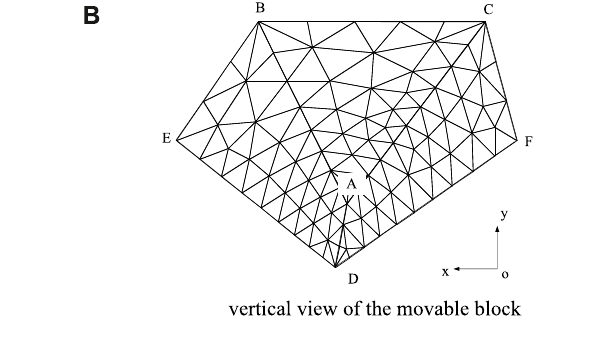
FIGURE 6 Three-dimensional model for example 4. (A) Geometry of a typical movable block forming by three discontinuities. (B) Vertical view of the movable block.